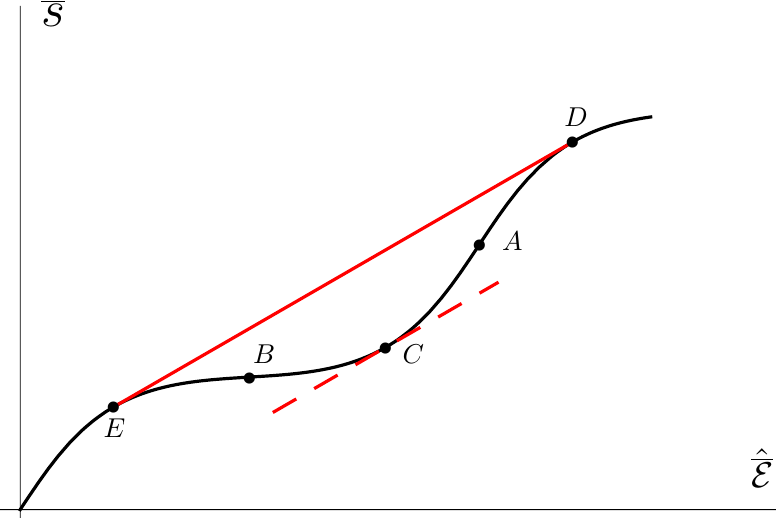
Figure 5 . Qualitative form of the entropy density in the microcanonical ensemble. The solid red segment corresponds to the average entropy density of phase-separated configurations, as explained in the text. The dashed red segment indicates that the slope of the tangent at point C is the same as that of the solid red segment. This follows from the fact that the temperature at point C is precisely T c